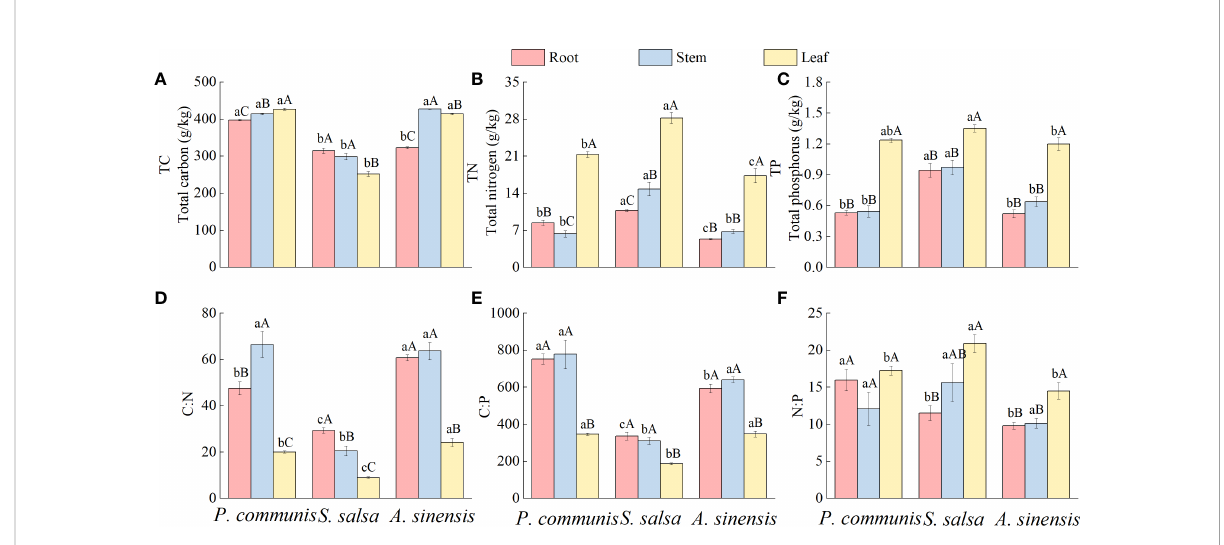
FIGURE 2 Characteristics of TC (A) , TN (B) and TP (C) contents and C:N (D) , C:P (E) and N:P (F) stoichiometric ratios in halophyte organs. Capital letters indicate the difference between different organs in the same halophyte, and lowercase letters donate the difference of different halophytes of the same organ ( P <